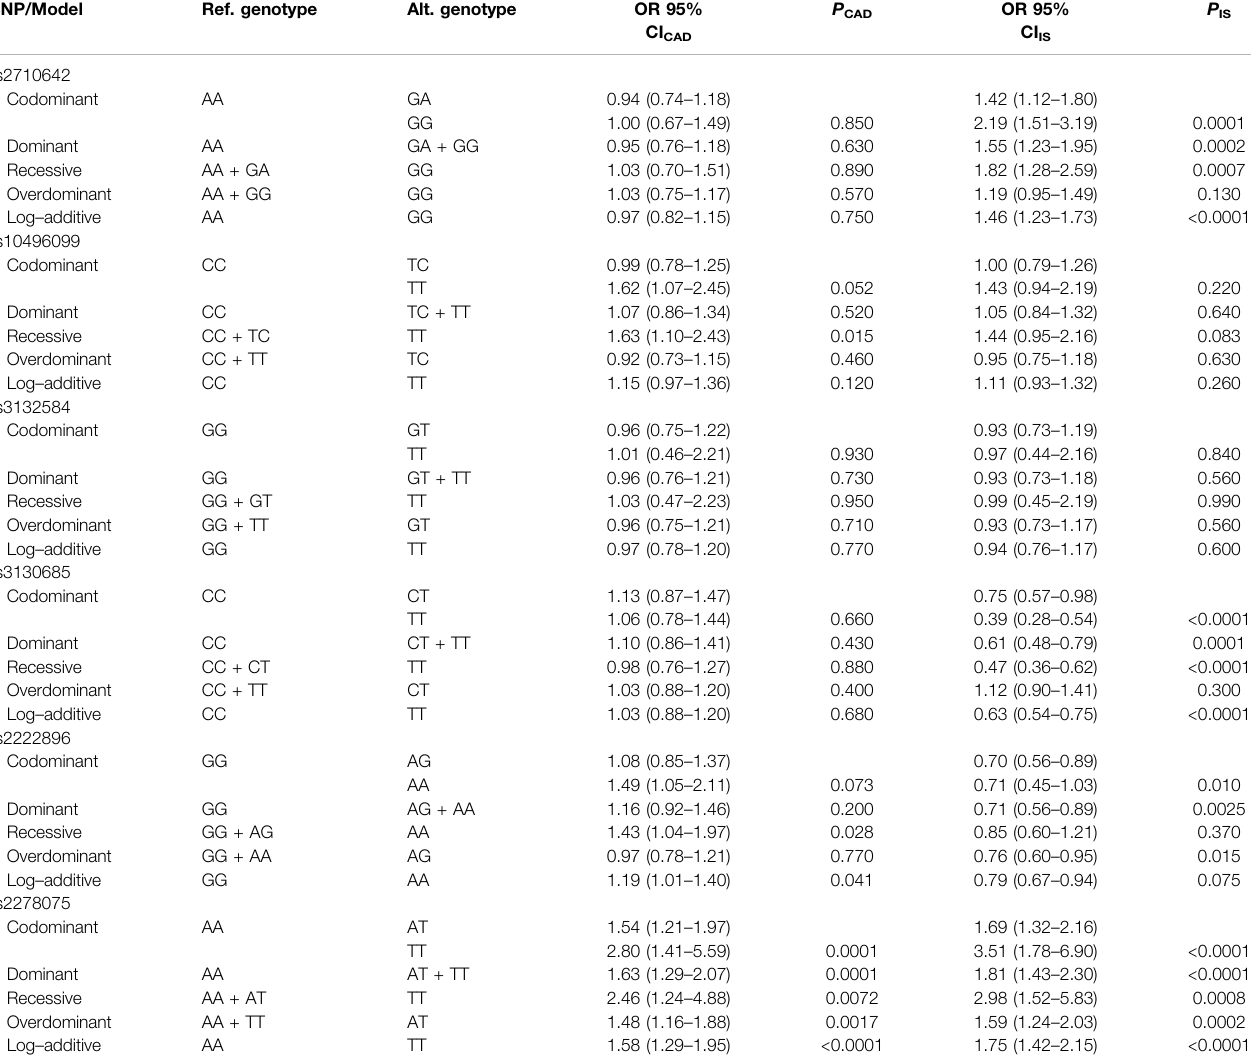
TABLE 3 | Associations between the EHBP1 , TUBB , and WWOX SNPs and CAD/IS.